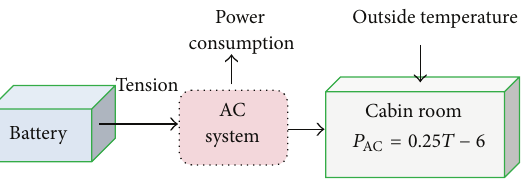
Figure 4: Model of the electric air-conditioning